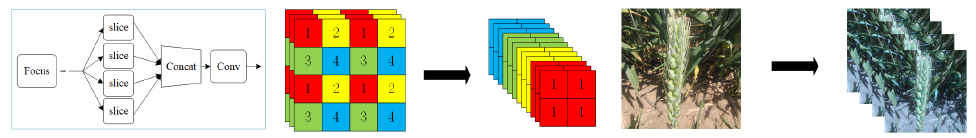
Figure 5. Focus slicing operation.